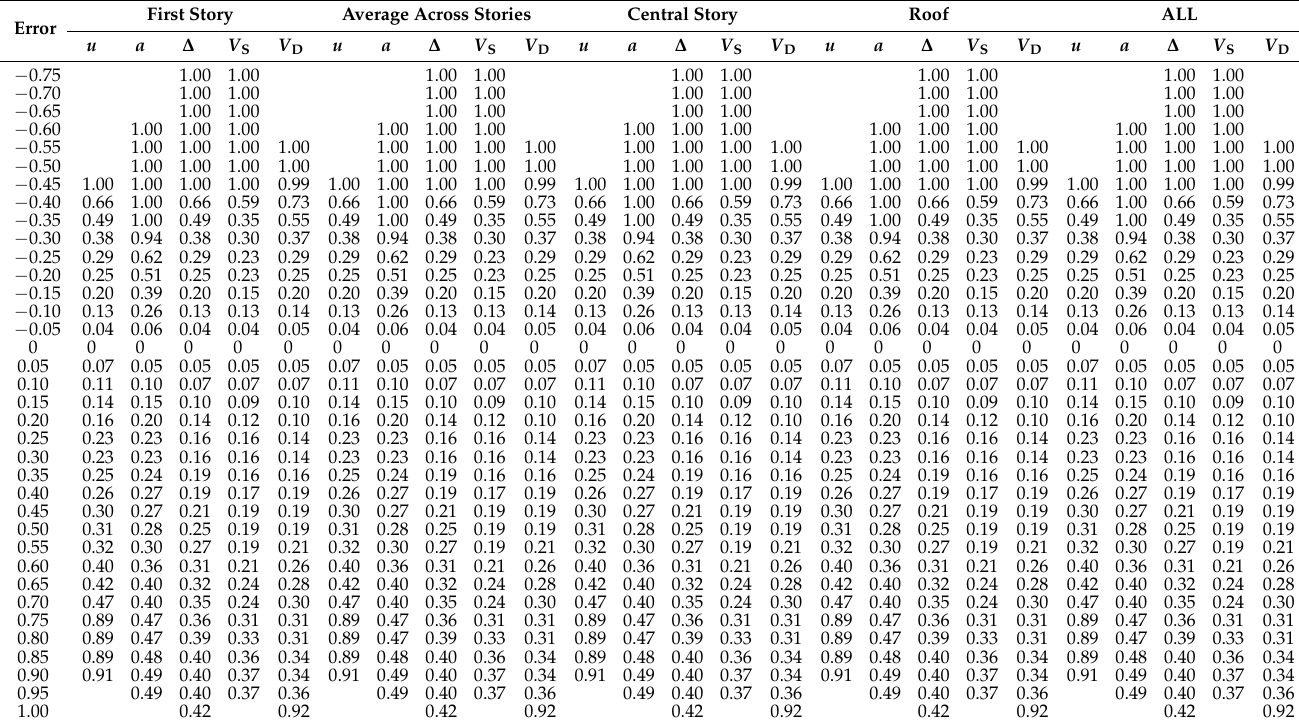
Table 8. Maximum value of I TLL 1 to limit the max and min THMA error (error 1).